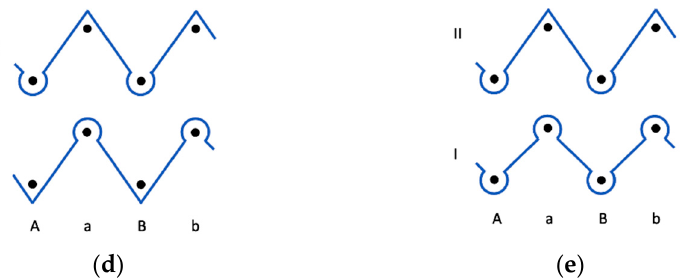
Figure 2. Graphic notation of the investigated knitted structures: ( a ) single tuck stitch; ( b ) Milano rib